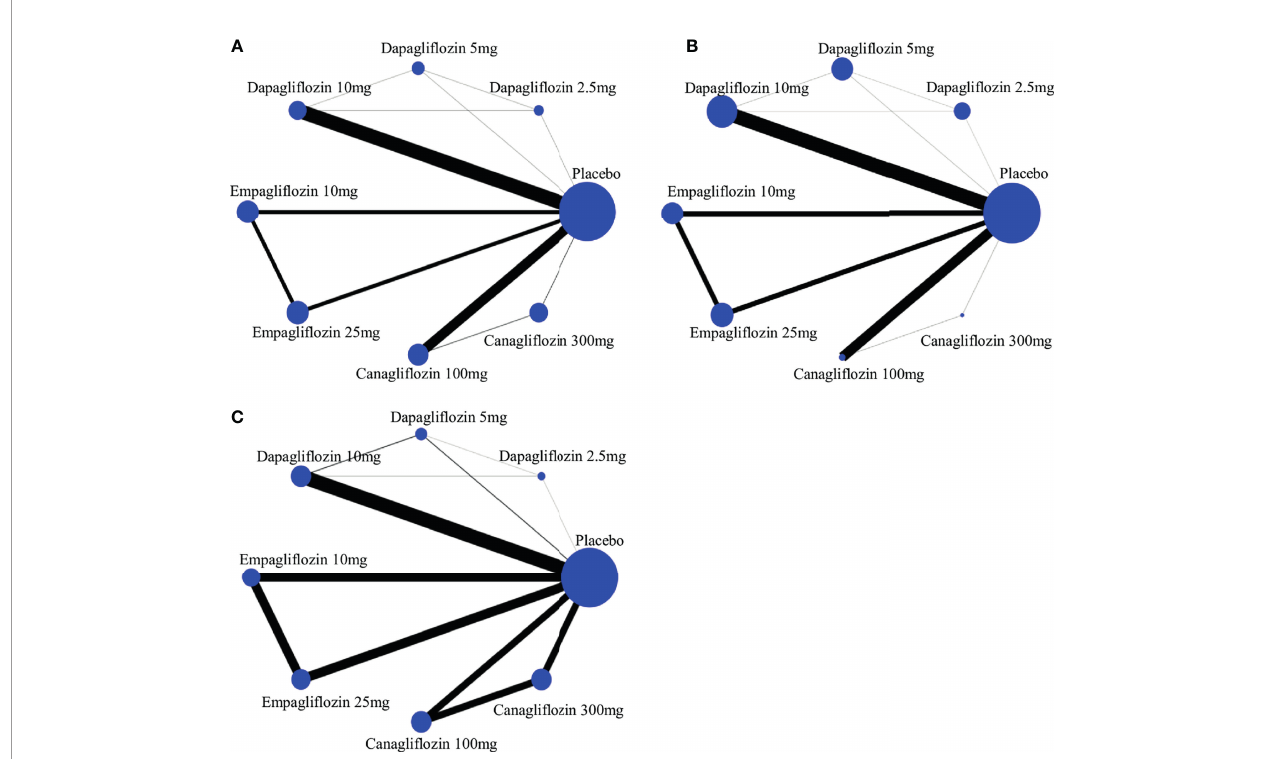
FIGURE 2 | The evidence network of studies reporting (A) all-cause death, (B) cardiovascular event and (C) volume depletion. The size of the nodes (blue circles) corresponds to the overall sample size of the corresponding intervention. Each line represents the direct comparison between the two interventions, and its thickness corresponds to the number of trials that assessed the comparison.